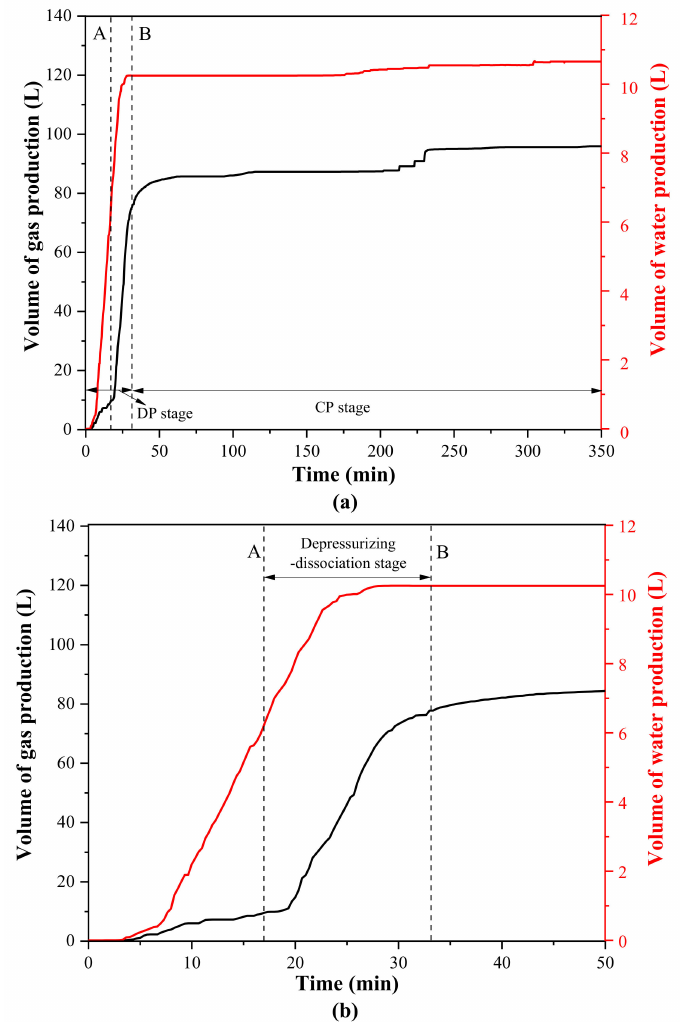
Figure 15. Changes of volumes of gas and water production during depressurization and hydrate dissociation processes. ( a ) Entire hydrate dissociation process. ( b ) The first 50 min for hydrate